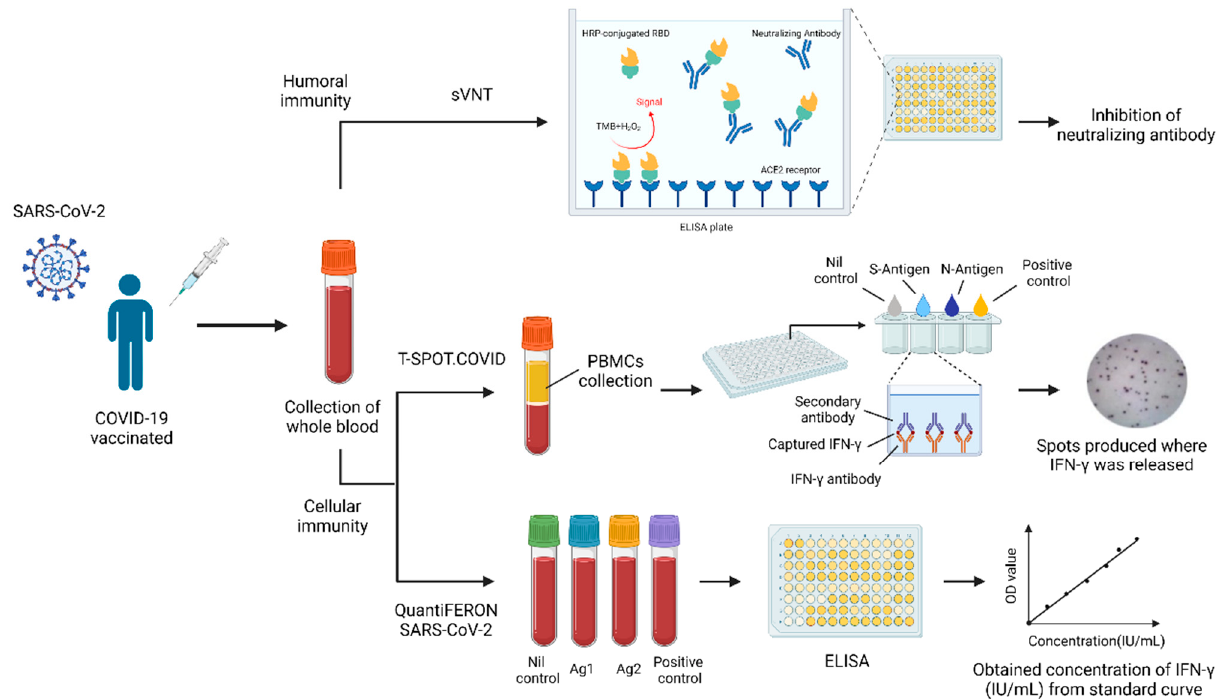
Figure 1. Summary of methods to evaluate COVID-19 vaccines’ effectiveness.